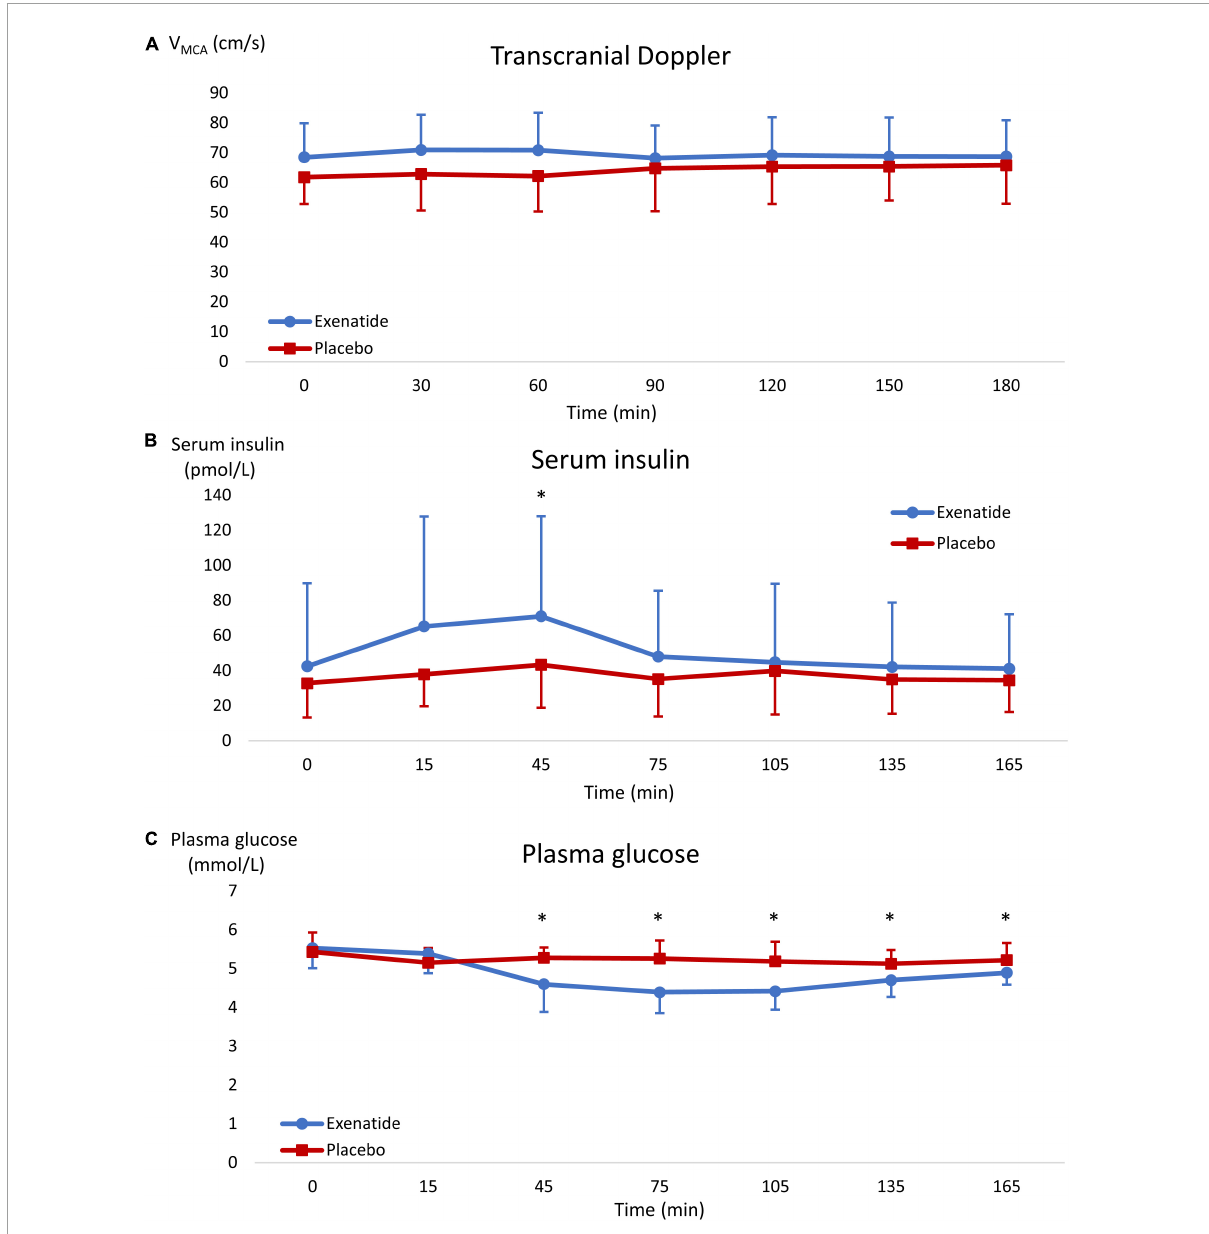
FIGURE2 Results graphs. Results are shown as mean ± SD. Blue data series represent the exenatide group and red represents the placebo group. Graph (A) shows Transcranial Doppler, graph (B) shows serum insulin, and graph (C) shows plasma glucose. *, significant difference between